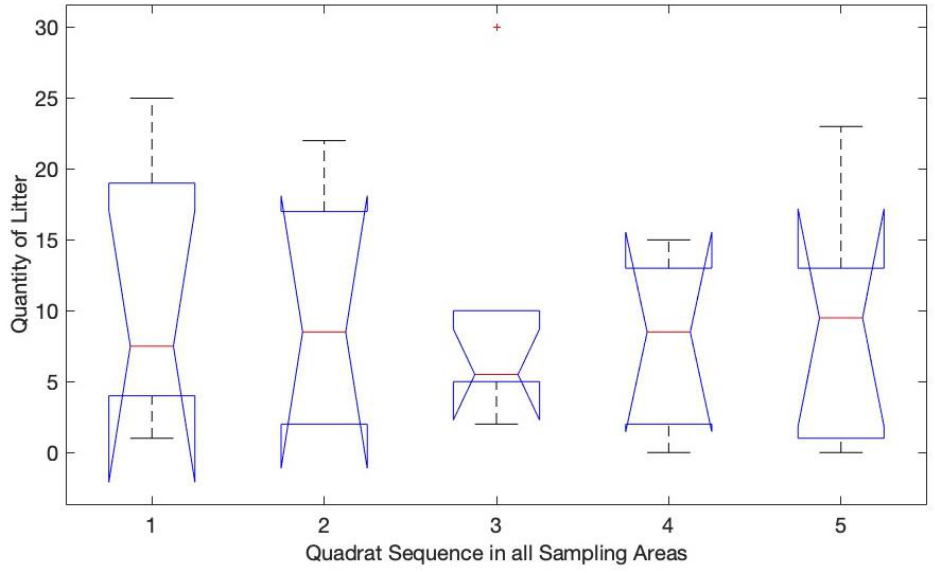
Figure 7. Result of Univariate Analysis of Variance in different sampling points from the survey.